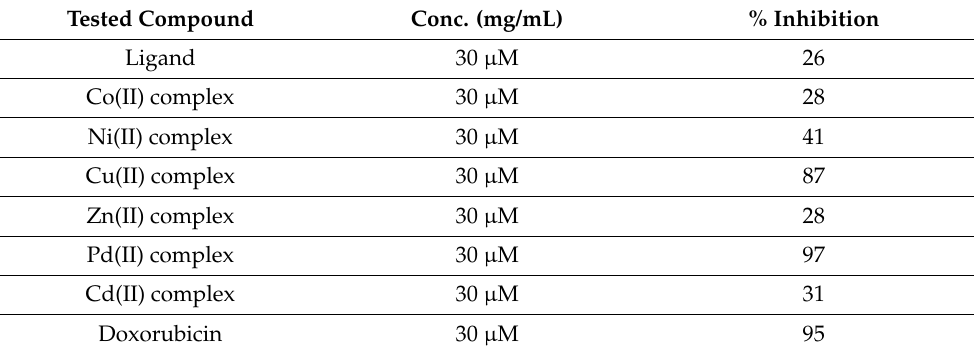
Table 5. Anti-cancer studies against Hela cancer cell